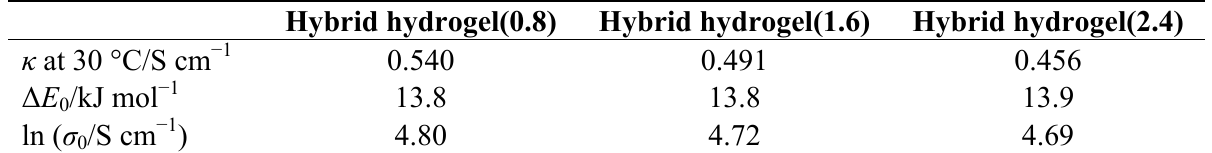
) for three hybrid hydrogel electrolytes. 0